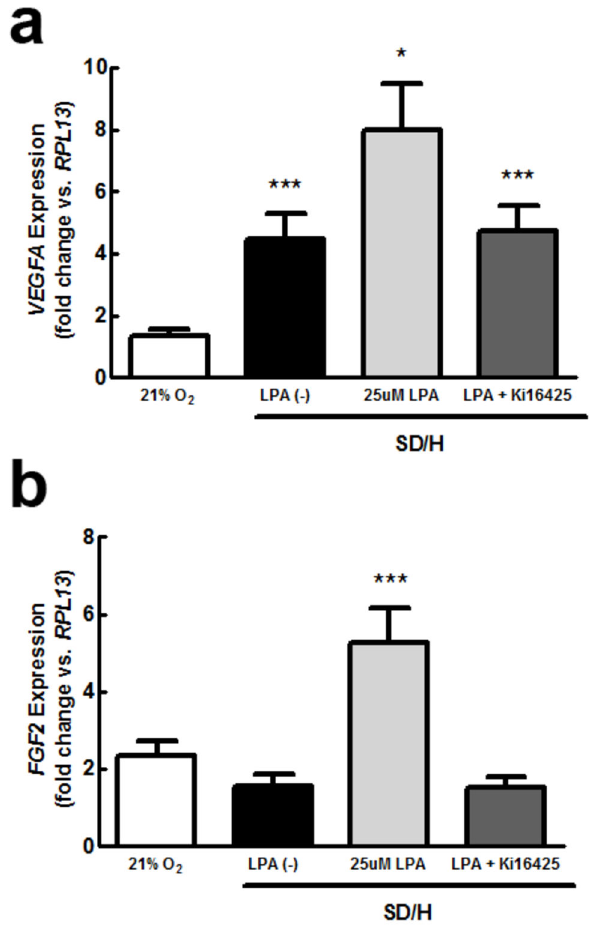
Figure 2. LPA enhances the proangiogenic effects of ASC under ischemia in vitro . Expression of ( a ) VEGF and ( b ) FGF2 are upregulated by SD/H and further enhanced with the addition of 25 μM LPA. In both cases, the addition of Ki16425 abrogates this effect ( n = 4). Data represents combined gene expression from three unique donors. * p < 0.05 vs. control, ** p < 0.01 vs. control, *** p < 0.001 vs.